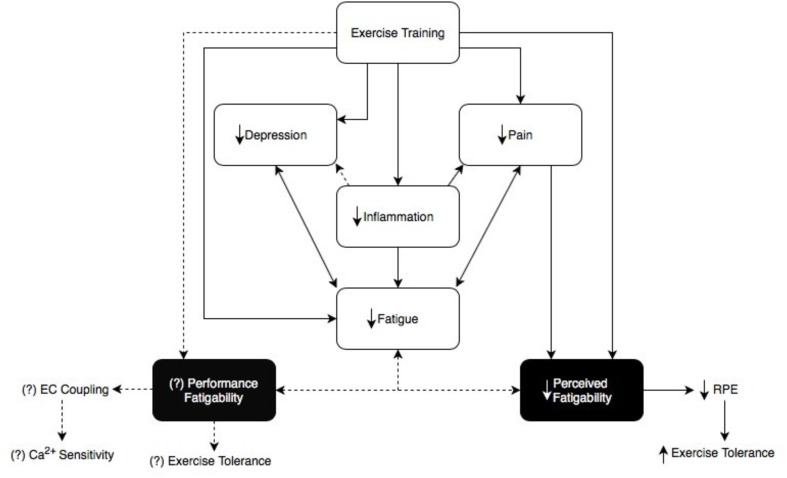
This figure demonstrates the link between fatigue, depression, pain, and inflammation (Nikolaus et al., 2013; Louati and Berenbaum, 2015). Fatigue in RA can be subdivided into ‘Perceived fatigability’ and ‘Performance fatigability’, each with different underlying mechanisms (Enoka and Duchateau, 2016). Exercise training shows a speculative relationship between perceived and performance fatigability (Cooney et al., 2011; Veldhuijzen Van Zanten et al., 2015). This diagram explains that not only does exercise training reduce inflammation and alleviate symptoms in RA patients, it may also help to decrease performance and perceived fatigability which may ultimately act upon and reduce one another as well (Cooney et al., 2011; Veldhuijzen Van Zanten et al., 2015). We propose there is a distinct relationship between exercise training and its effects on performance and perceived fatigability relating back to the overall symptom of fatigue in this clinical population. Dotted lines represent the speculative relationship between exercise training and performance fatigability, as well as performance fatigability and perceived fatigability.